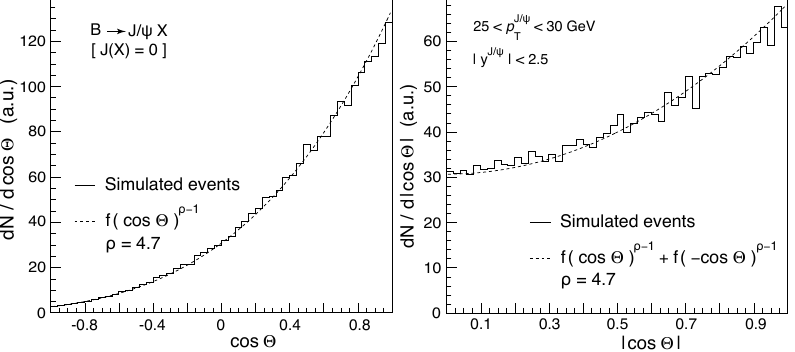
Figure 7 . The cos Θ (left) and | cos Θ | (right) distributions, in the B HX frame, of simulated B → J /ψ X events with unobserved X , for 25 < p J /ψ < 30 GeV. The exponent ρ , determined by fitting T the p T distribution (figure 6), provides a good analytical description of the angular distributions.